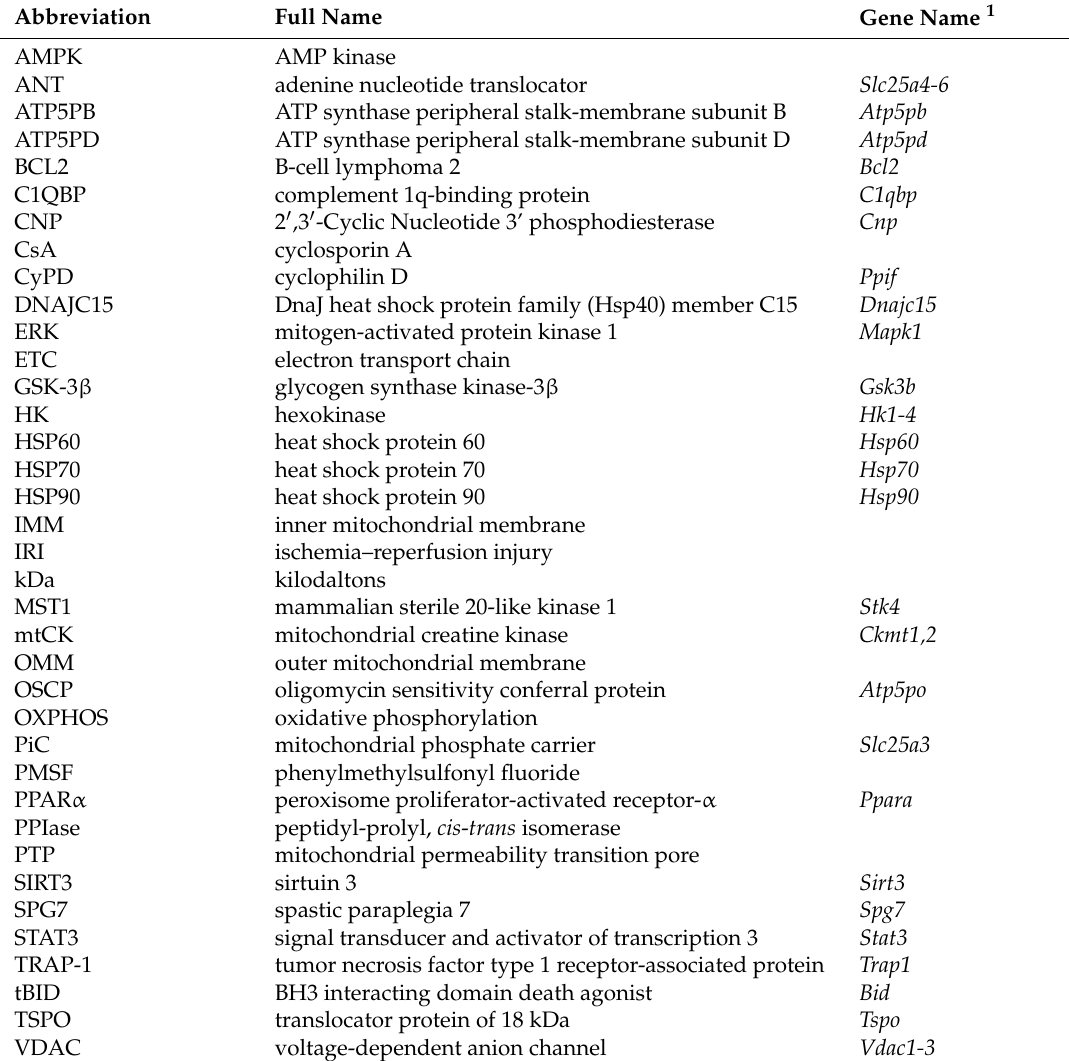
Table 1. List of